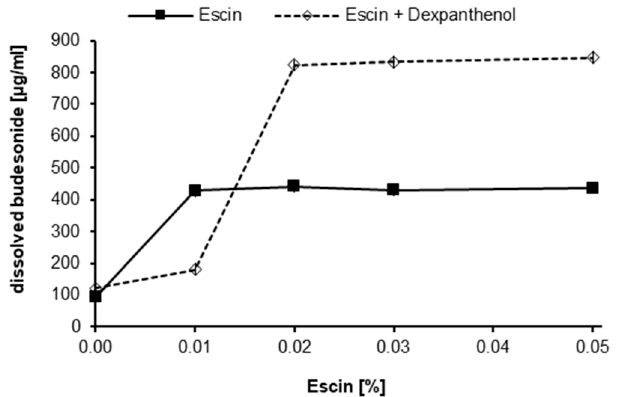
Figure 1. Effect of escin and dexpanthenol on the solubilization of budesonide. Concentrations of budesonide ( µ g / mL, x -axis) determined by RP-HPLC in formulations containing 0–0.05% escin ( y -axis) with and without 6% dexpanthenol measured after 6 days stored at room temperature. Data are expressed as mean ( n = 2).